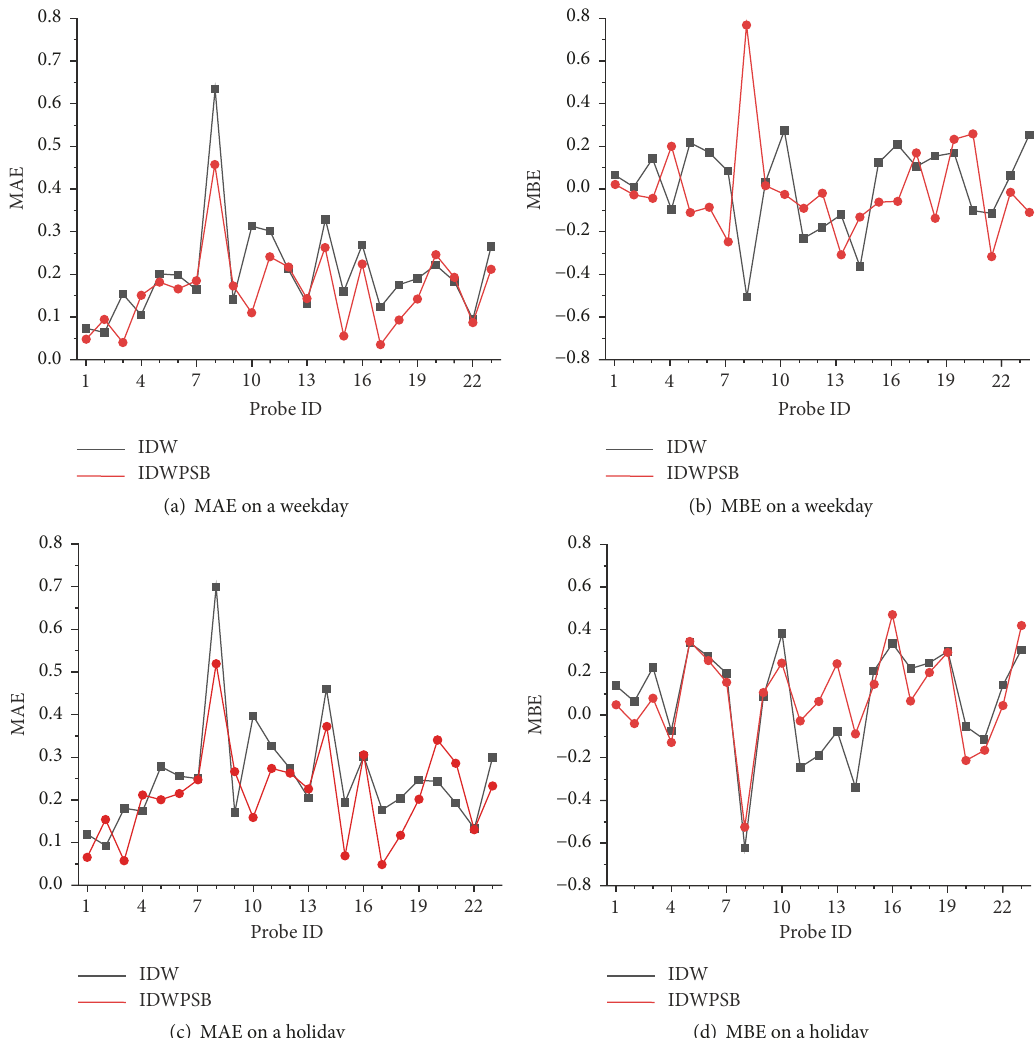
Figure 5: Comparison of the interpolation results in MAE and MBE between the IDW and IDWPSB methods.